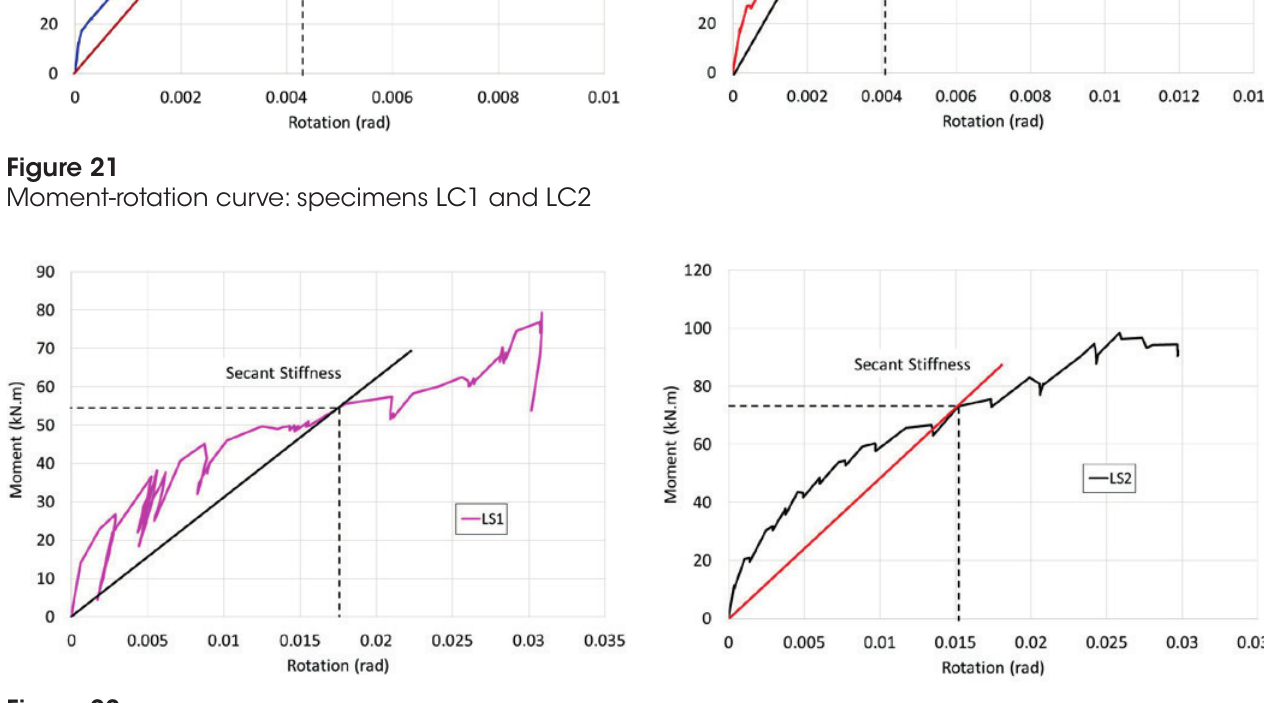
Figure 22 – Moment-rotation curve: specimens LS1 and LS2